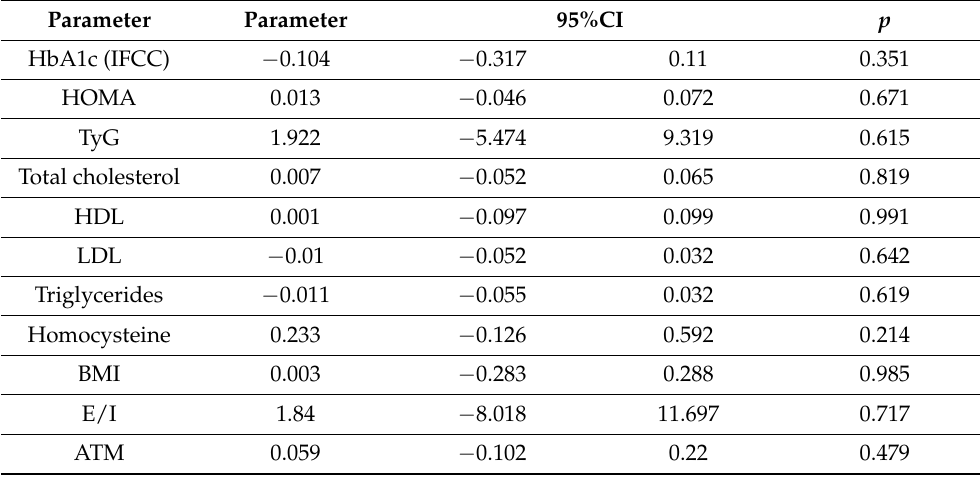
prepartum serum (Table 5) or postpartum serum (Table 6) and urine (Table 7). Table 5. Galectin-9 in serum before